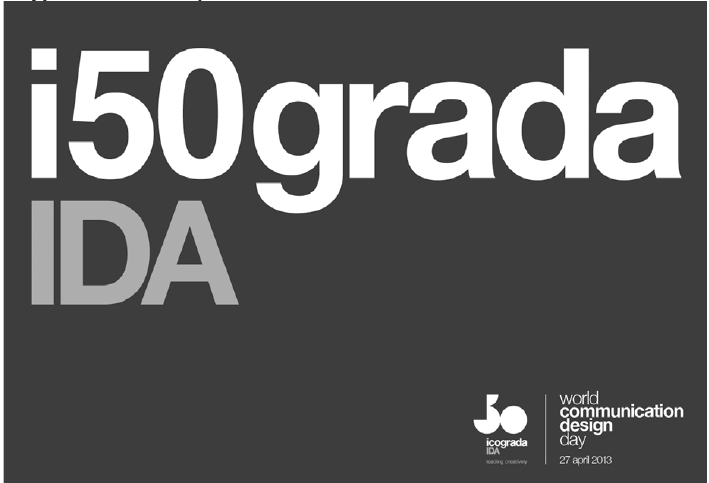
Fig. 8. Christopher Scott: ICOGRADA’s 50th Anniversary